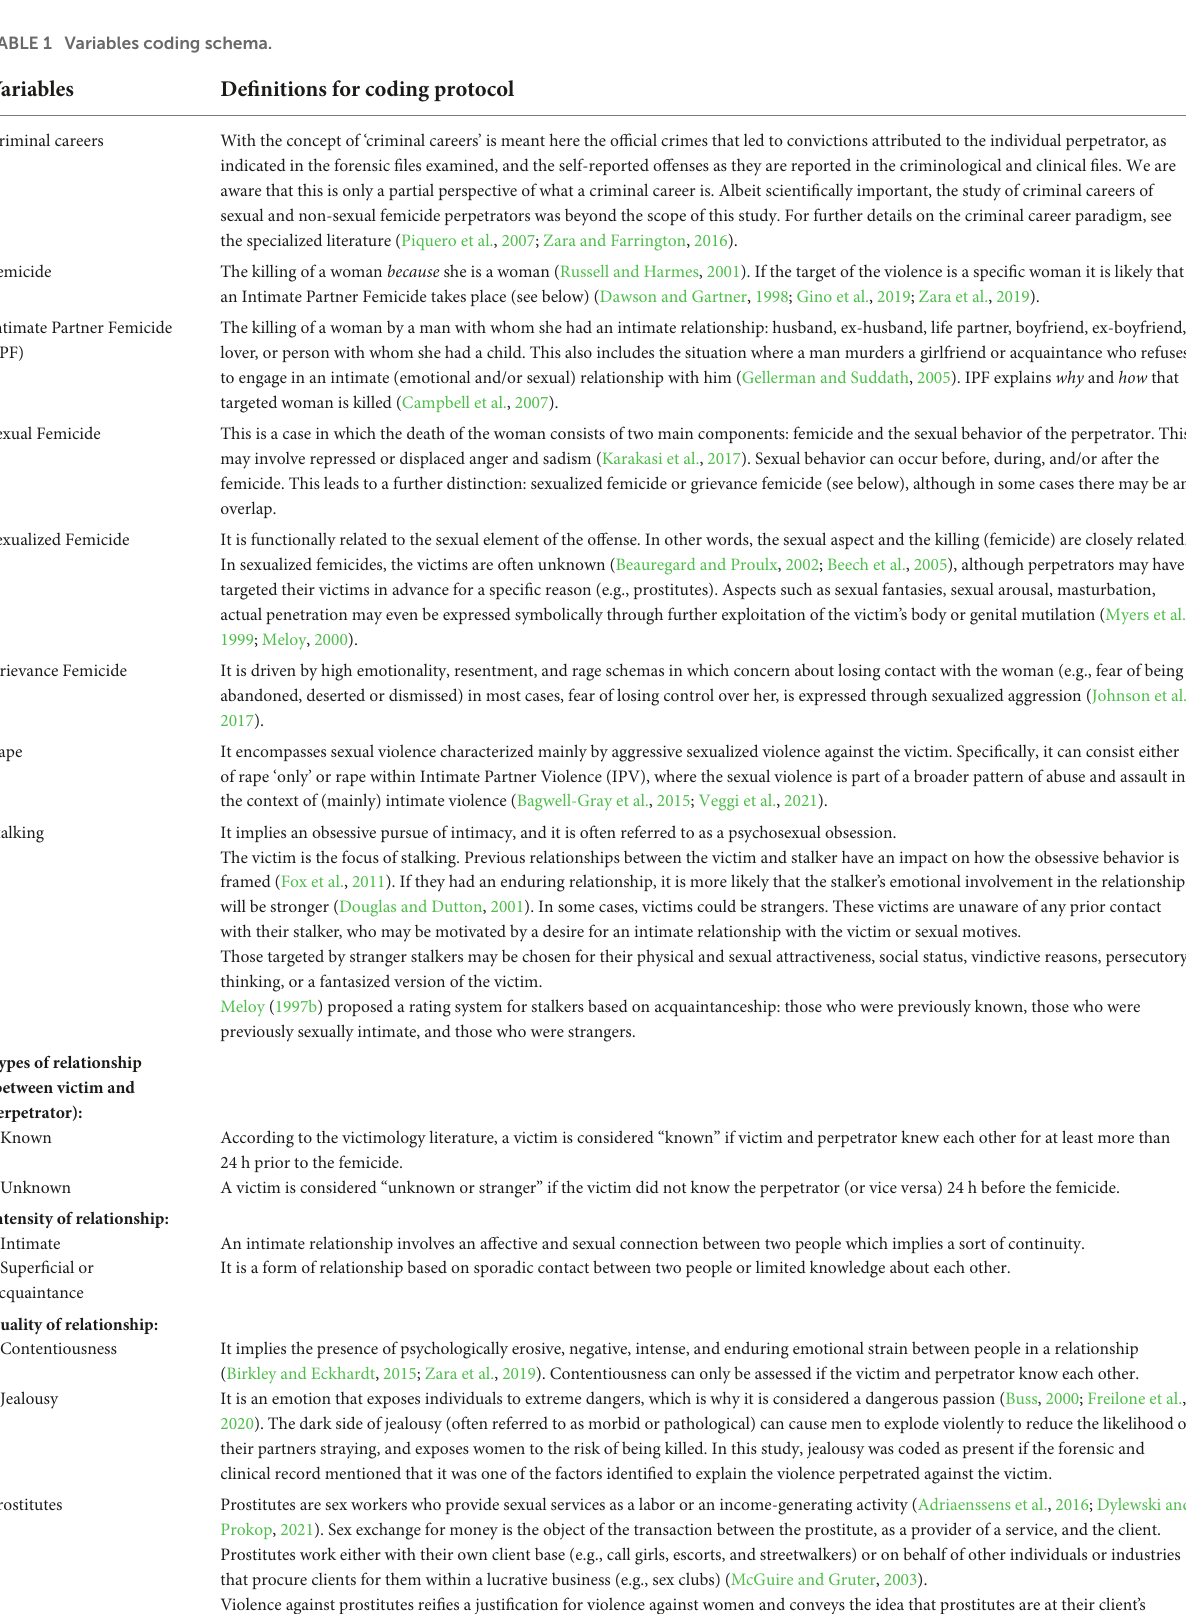
TABLE 1 Variables coding